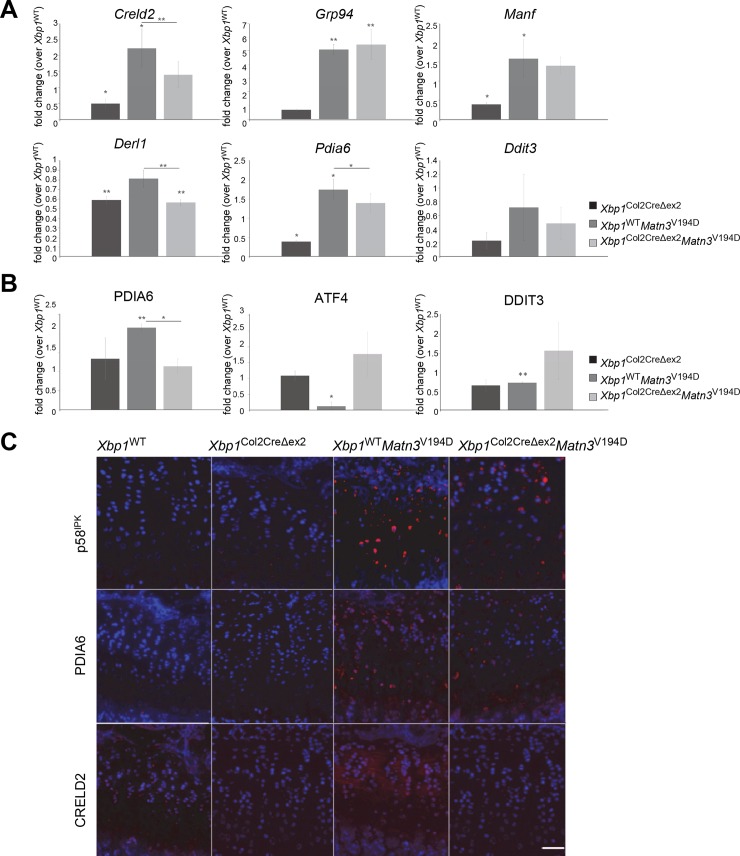
(A) Real time RT-qPCR of genes downstream of XBP1, XBP1/ATF6 and PERK signalling. Creld2, Derl1 and Pdia6 (downstream of XBP1) follow an XBP1 dependent pattern of expression, and are upregulated in EDM5 cartilage and decreased upon deletion of XBP1. Grp94 and Manf (downstream of ATF6 and/or XBP1) appear to be ATF6-dependent in EDM5 cartilage and are not affected by lack of XBP1 in Xbp1Col2CreΔex2
Matn3V194D tissue. The mRNA levels of Ddit3 (Chop), a downstream effector of PERK, are not changed in any of the mouse lines analysed. (B) Densitometry measurement of 3 independent biological replicates of Western blotting for PDIA6 (downstream of XBP1), and ATF4 and DDIT3 (CHOP) (both downstream of PERK), showing a decrease in PERK effector levels in EDM5 cartilage. (C) Immunohistochemical staining of 3 week old cartilage growth plates showing a decrease in p58IPK, PDIA6 and CRELD2 staining (red) upon XBP1 deletion in the EDM5 cartilage. DAPI (blue) was used as a counterstain (blue). Key: * P<0.05, ** P<0.01, scale bar 100μm.